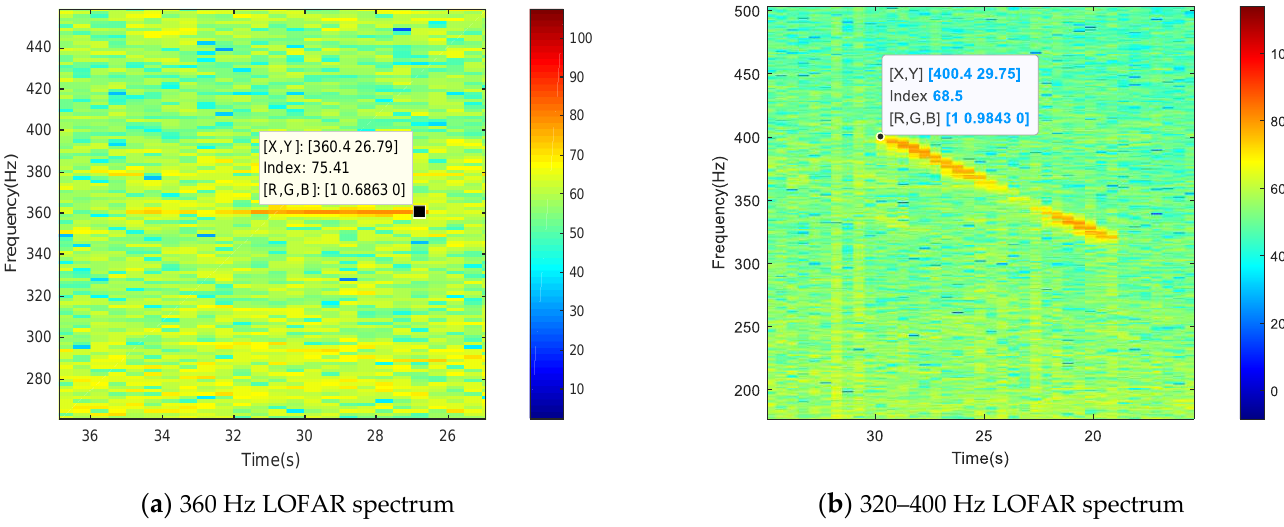
Figure 9. Low-Frequency acquisition and ranging ( LOFAR) spectrum.